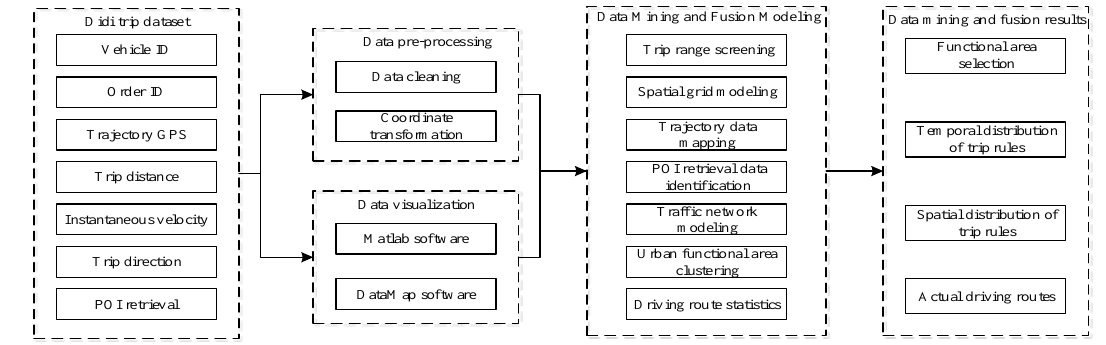
Figure 2. Analysis process of data mining and fusion.